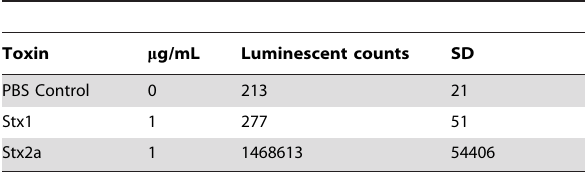
Table 3. Toxin specificity of the polyclonal antibody tested by direct ELISA.